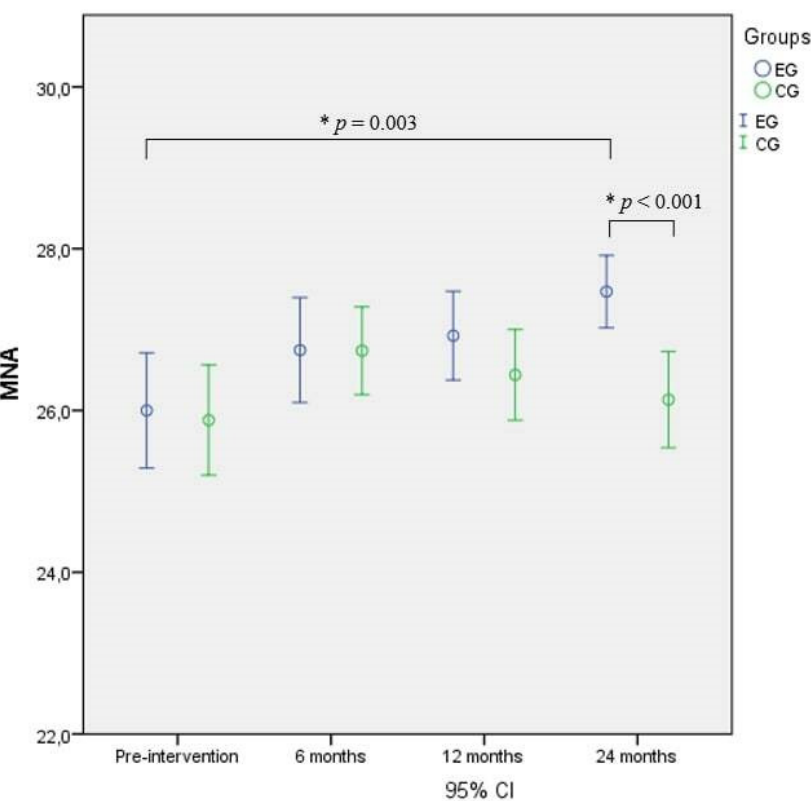
Figure 3. Mini nutritional assessment (MNA) comparison between and within groups. * = Significant difference.